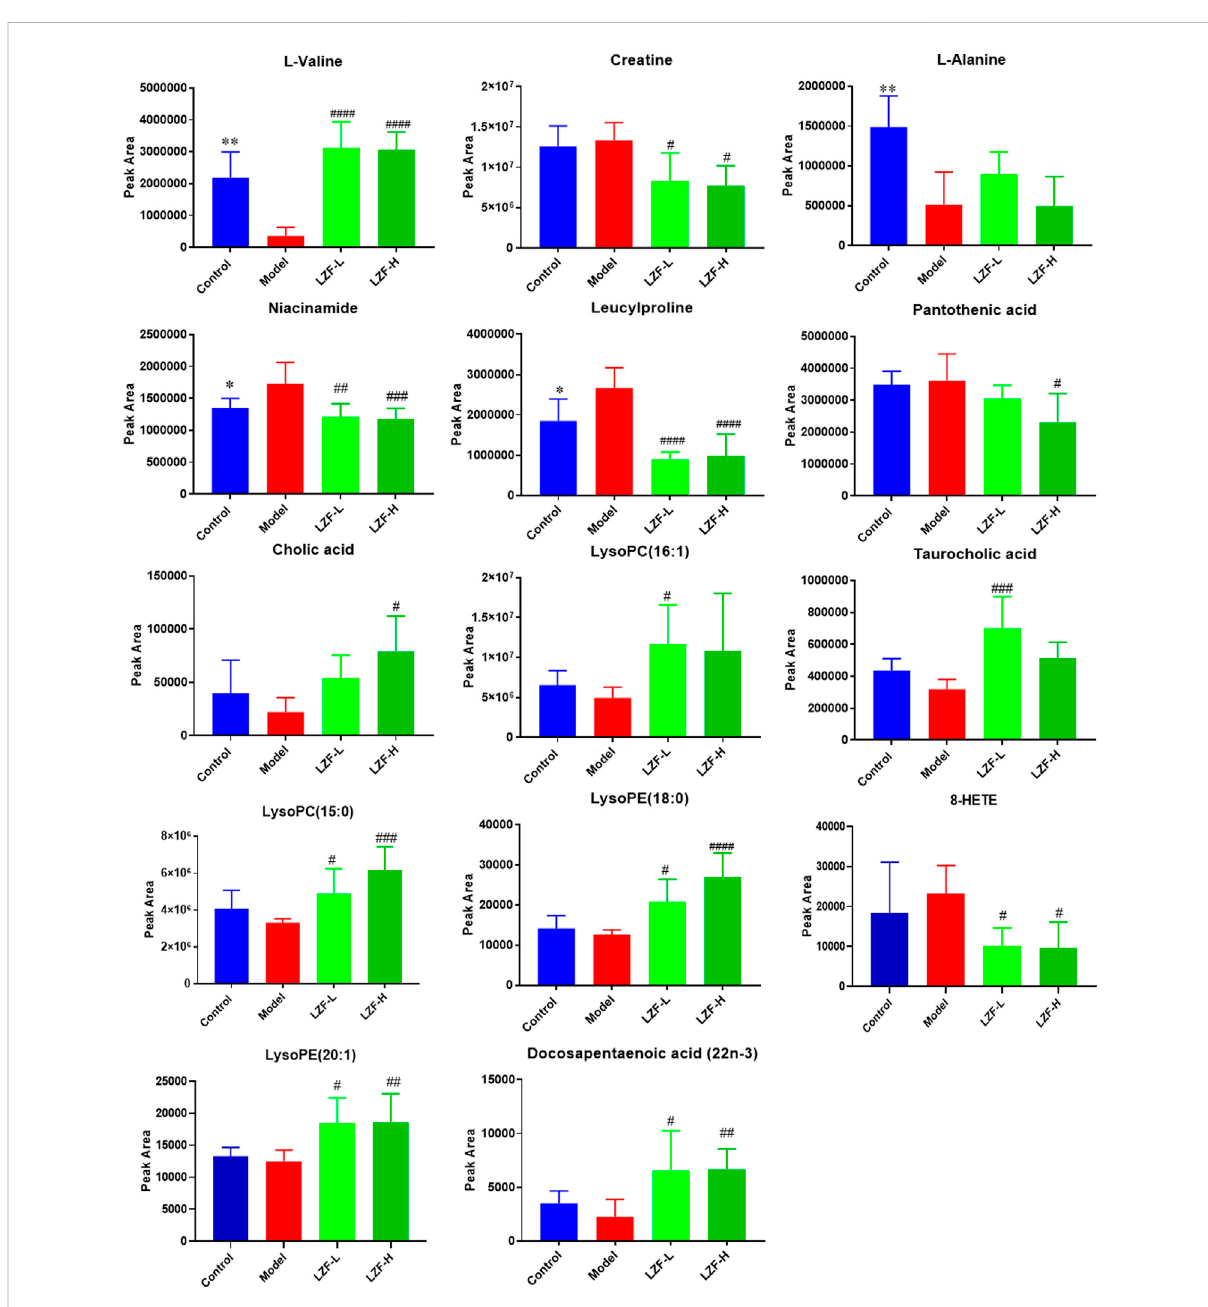
FIGURE 3 Peakareaanalysisof14differentialmetabolites(* p < 0.05,** p < 0.01,*** p < 0.001,controlgroupvs.modelcontrol; # p < 0.05, ## p < 0.01, ### p < 0.001 low-dose, LZF solution group vs. model